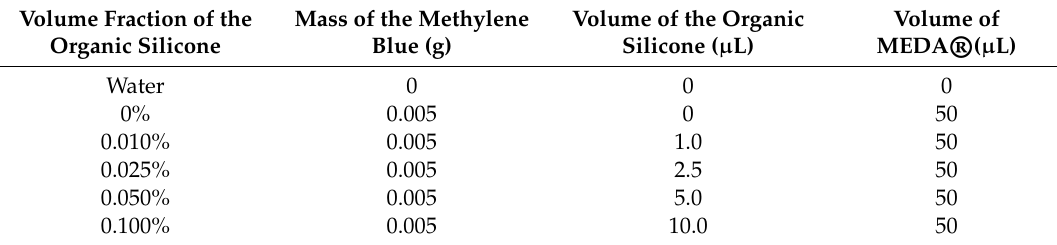
Table 1. Concentrations of the spray mixture components for the preparation of 10 mL application mixture.